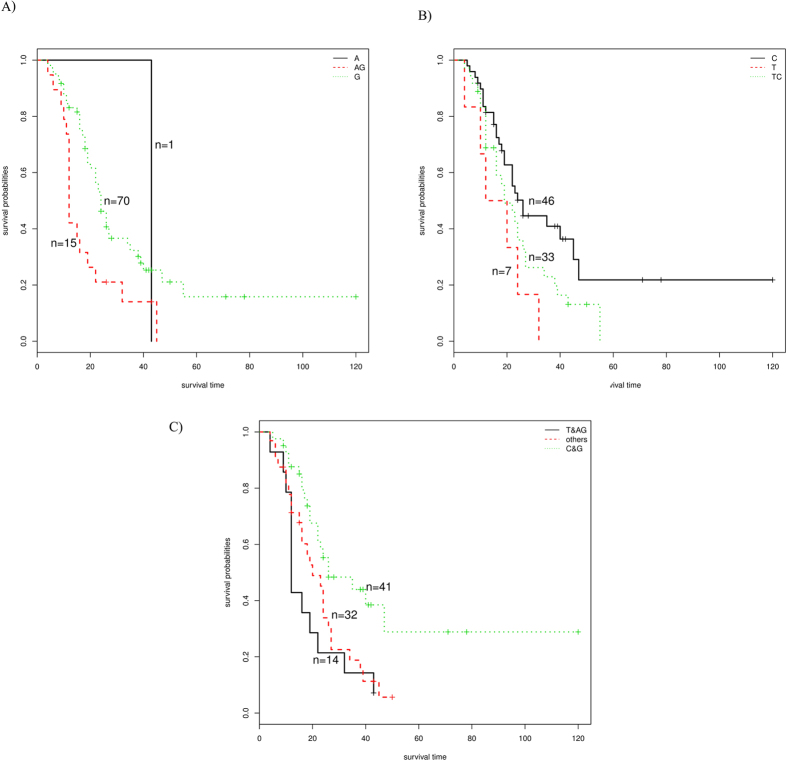
Stepwise regression analysis results of SNP rs2273953 (TP73) and rs12334811 (DNPK1) in squamous cell carcinoma patients (A) rs12334811(DNPK1) (B) rs2273953(TP73) (C) Conjoint analysis of rs12334811(DNPK1)and rs2273953(TP73).